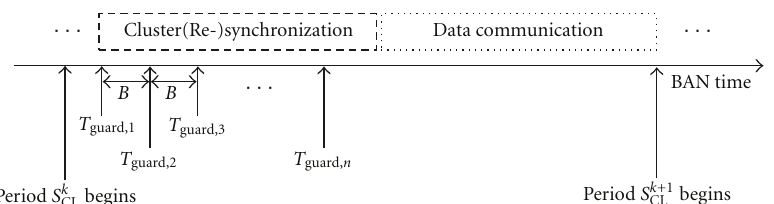
Figure 1: BAN and node-dependent times of guard.